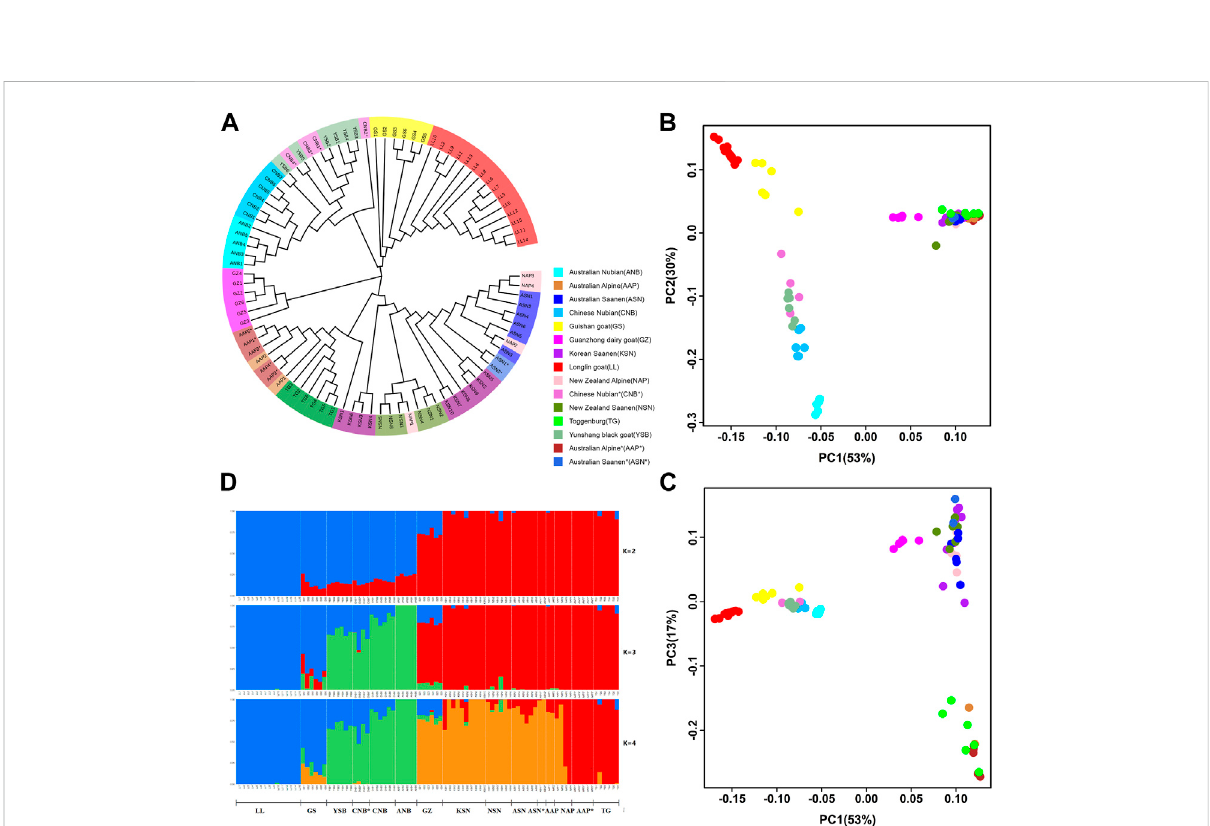
FIGURE 2 (A) Neighbor-joining (NJ) tree of the 89 individuals based on the matrix of Hamming genetic distance, different colors represent different populations. (B) Plots of the fi rst and thesecond principal components for the89 individuals. (C) Plotsof the fi rst and the third principal components for the 89 individuals. (D) Ancestry proportions of each sample using k = 2 –